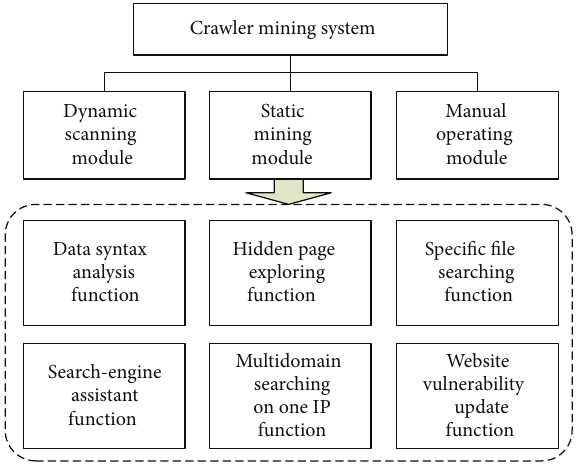
Figure 1: Crawler mining system framework.